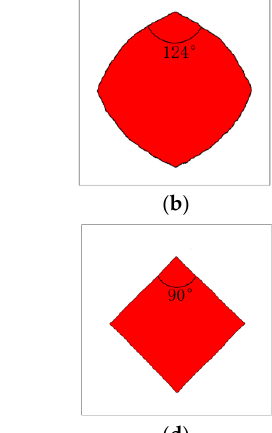
simulation shape with δ = 4 ; ( c ) δ = 16 ; ( d ) δ = 64 ; λ = 10 ( b ) the